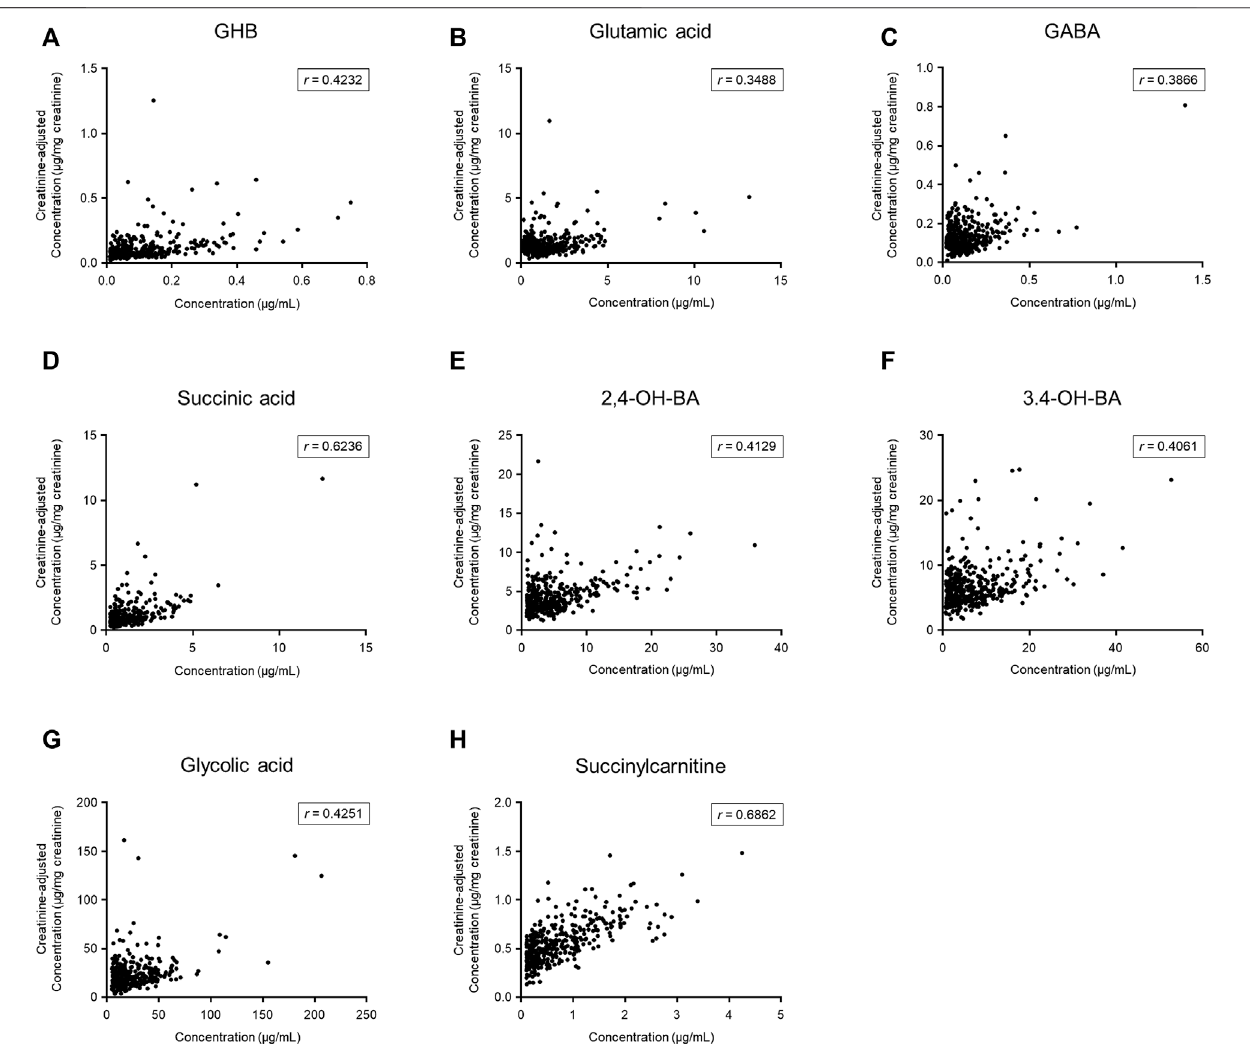
Frontiers in Pharmacology |